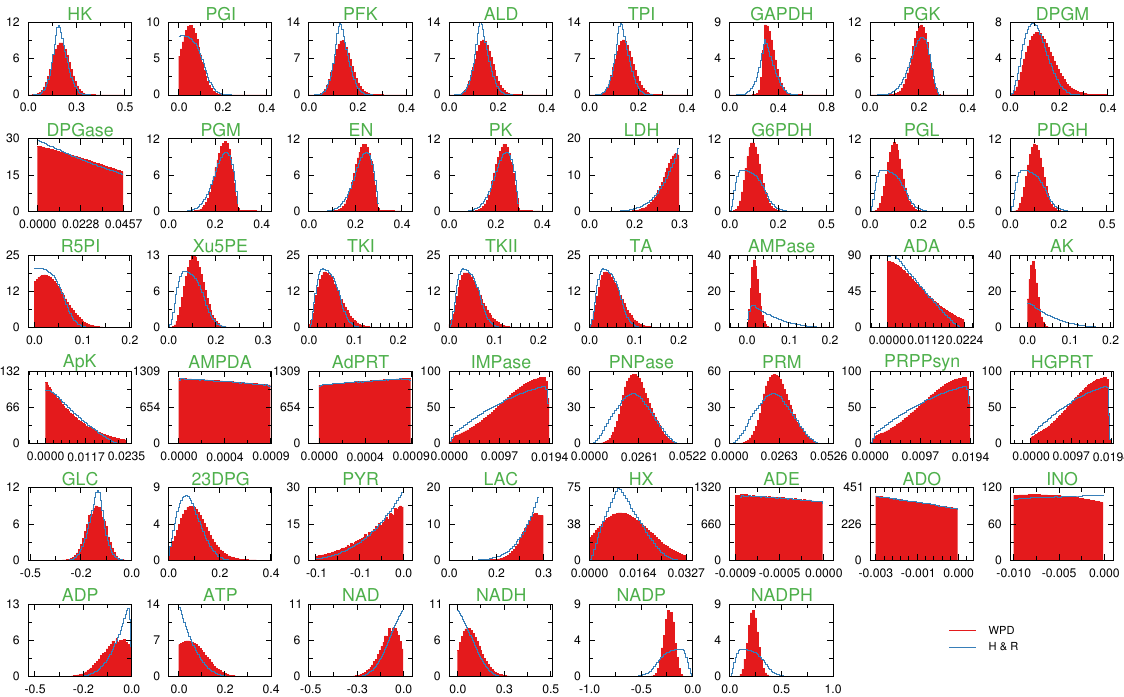
Figure 6. Results for human red blood cell. The probability density functions of the reaction rates; reaction names are the same as [9]. For the densities, we have used the wBP method (red filled plots) and have compared them with the Kernel Hit-and-Run (KHR) algorithm (blue solid lines). Note that the flux ranges span different orders of magnitude, but still, the profiles are very smooth for both weighted population dynamics and the Kernel Hit-and-Run